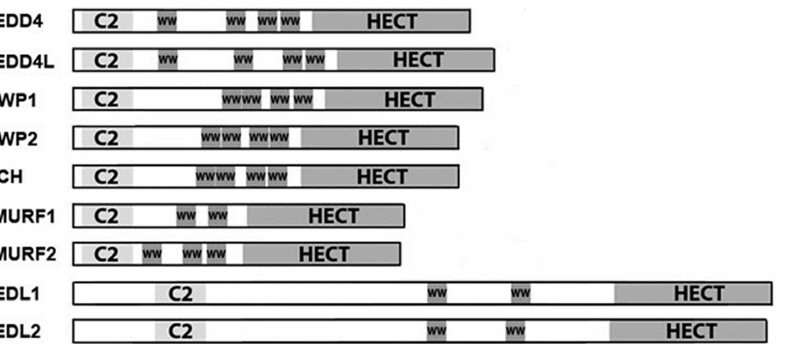
Figure 1. The NEDD4 family of E3 ubiquitin ligases. The nine members of the NEDD4 family are modular proteins. At their N-terminus, each has a C2 domain, which plays a role in proper cellular localization. The central portion of each protein contains two-to-four WW domains, which are responsible for target recognition. WW domains are 20–23 amino acid, Trp-based motifs that recognize PY motifs (PPXY, LPXY), as well as some phospho-Ser- or phospho-Thr-based motifs. At the C-terminus is the HECT domain, which directly conjugates an ubiquityl moiety to the target protein. The family members are grouped together by name and homology. ITCH is more closely homologous to WWP1 and 2 than to other family members.